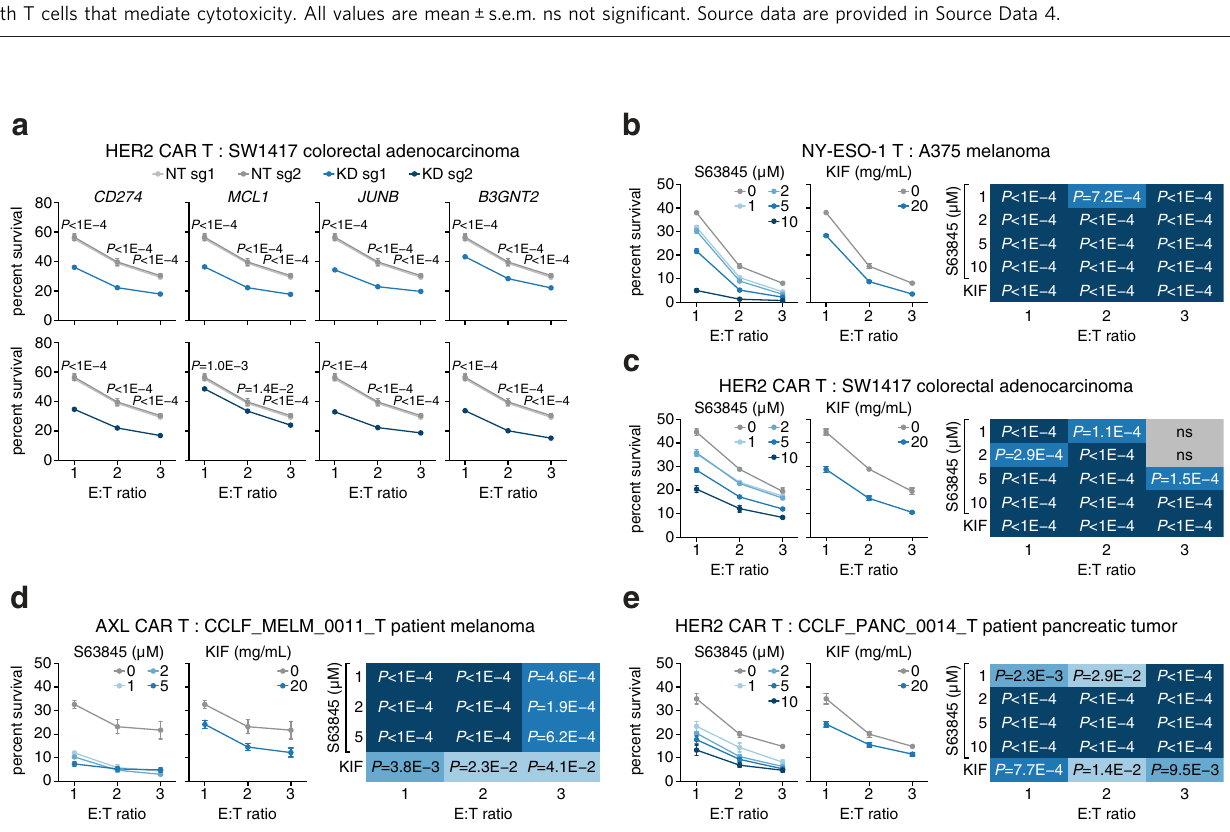
Fig. 5 Inhibition of candidate genes sensitizes tumors to T cell cytotoxicity. a Cell survival against HER2 CAR T cell cytotoxicity in SW1417 (HER2 + ) colorectal adenocarcinoma with different candidate genes knocked down using CRISPRi and 2 sgRNAs per gene. KD, knockdown. NT non-targeting. b – e Cell survival against T cell cytotoxicity in tumor cells treated with MCL1 or B3GNT2 small-molecule inhibitors, S63845 and kifunensine, respectively. Heatmaps show the signi fi cance of statistical analyses for each condition. b A375 (NY-ESO-1 + , HLA-A2 + ) melanoma against ESO T cells. c SW1417 (HER2 + ) colorectal adenocarcinoma against HER2 CAR T cells. d CCLF_MELM_0011_T (AXL + ) primary patient-derived melanoma model against AXL CAR T cells. e CCLF_PANC_0014_T (HER2 + ) primary patient-derived pancreatic adenocarcinoma against HER2 CAR T cells. All values are mean±s.e.m with n = 8. ns not signi fi cant. Two-tailed t tests with adjustments for multiple comparisons were performed. Source data are provided in Source Data 5.